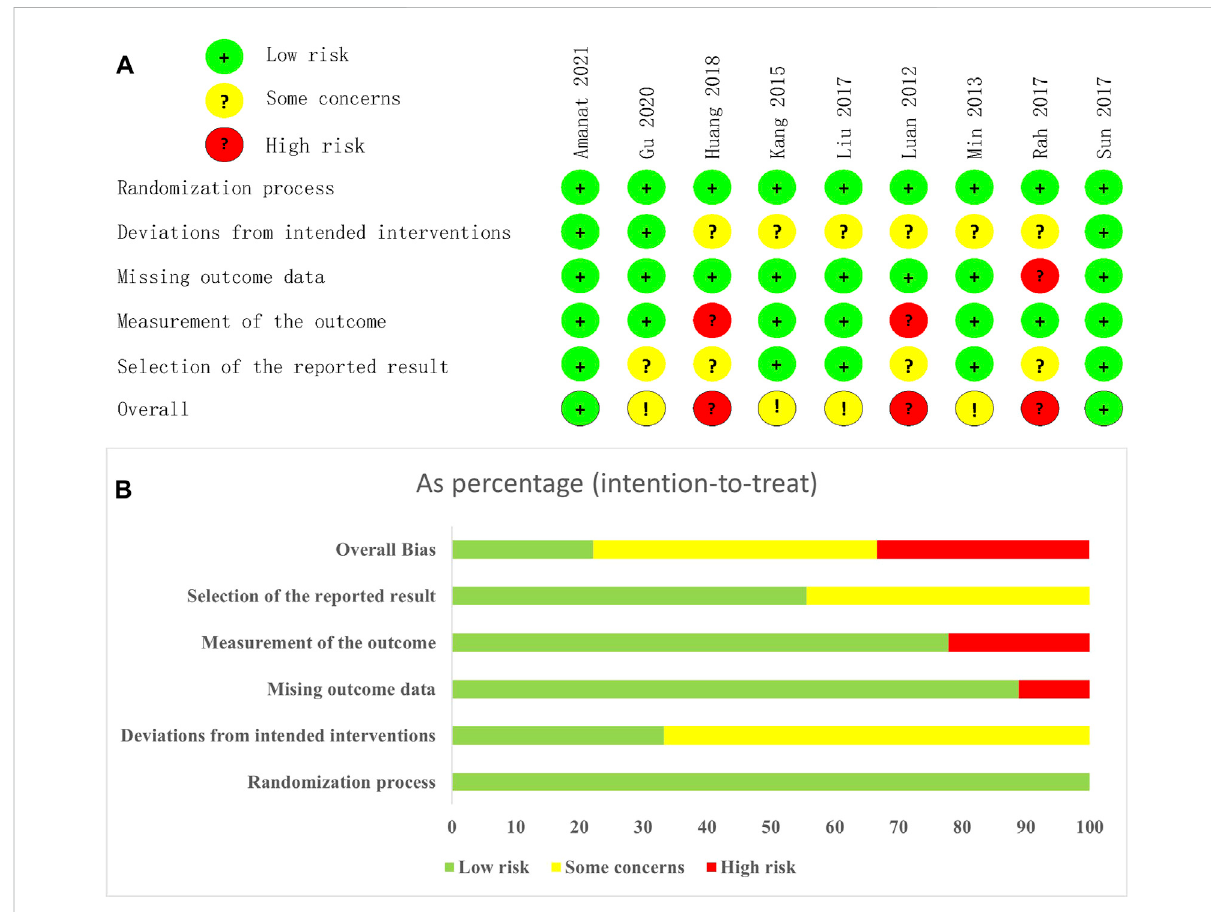
Risk of bias graph. (A) each risk of bias item for each included study. (B) each risk of bias item presented as percentages across all included